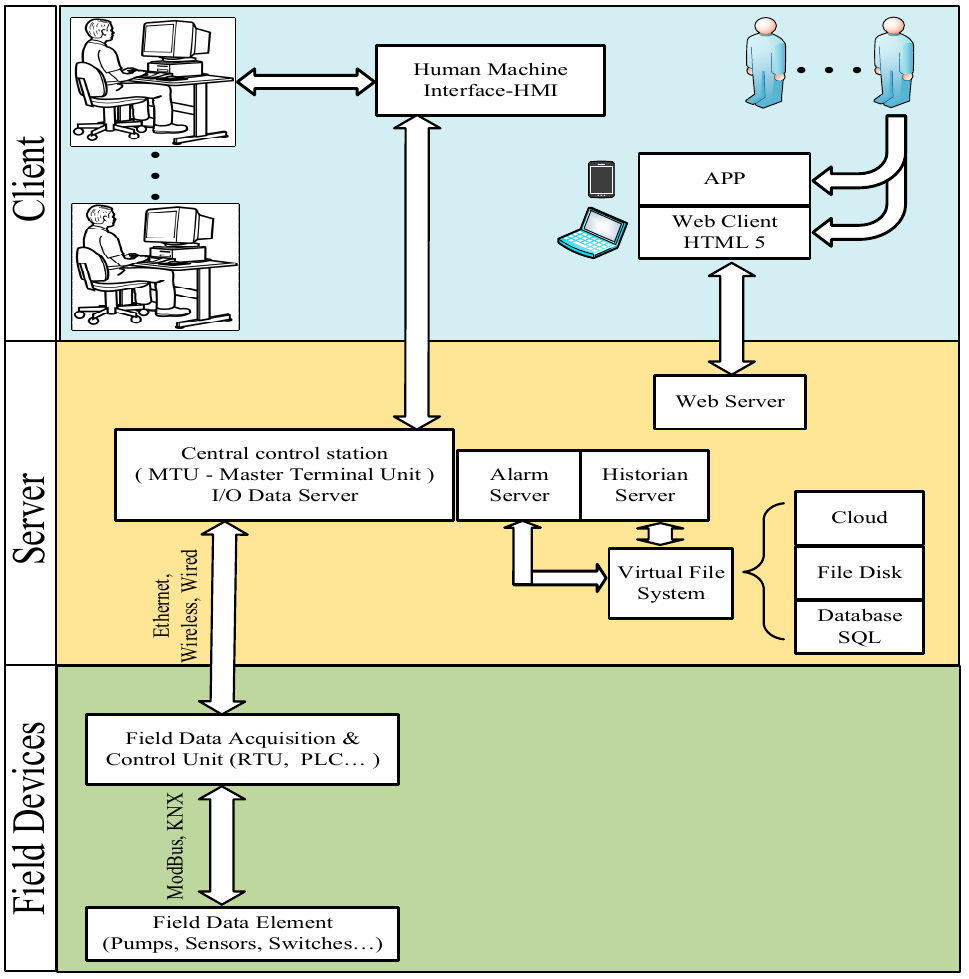
Figure 6. Client–server architecture of the SCADA system implemented in the LAMBDA MG LAB.